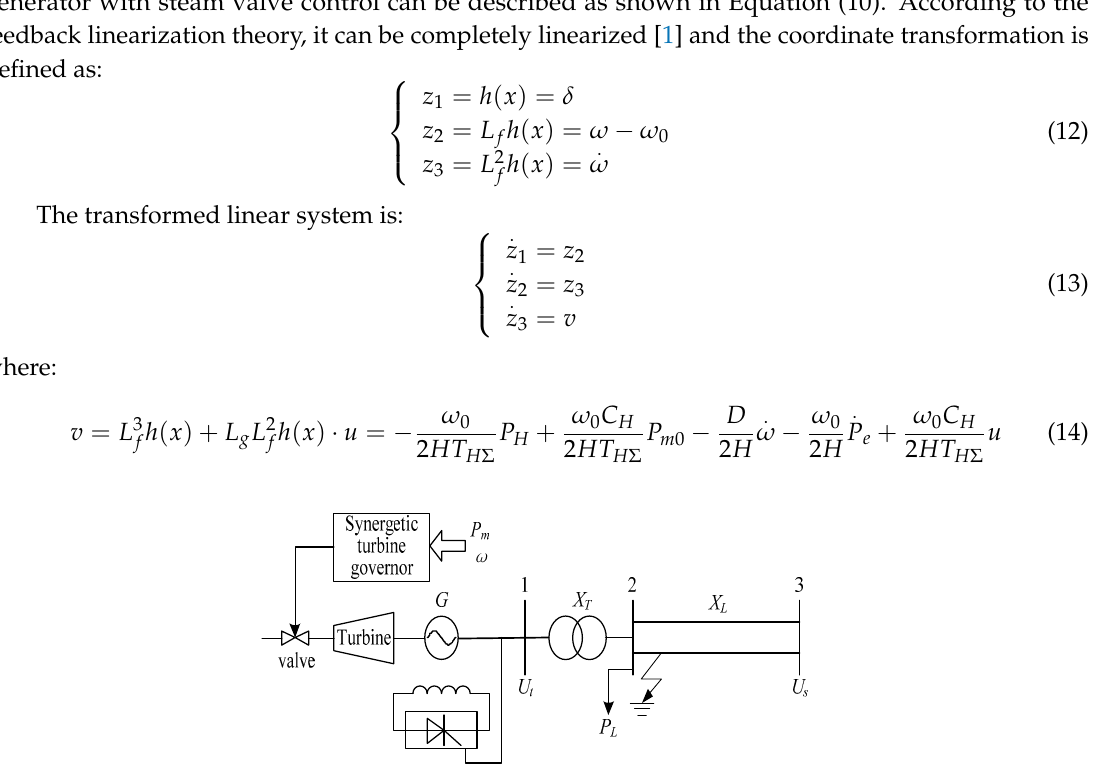
Figure 2. Single-machine infinite-bus power system with synergetic turbine governor.